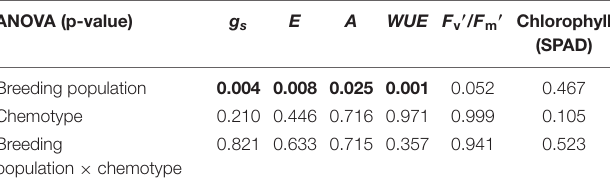
TABLE 4 | The results of two-way analysis of variance (ANOVA) (factors: breeding population, chemotype) for stomatal conductance ( g s ), transpiration ( E ),